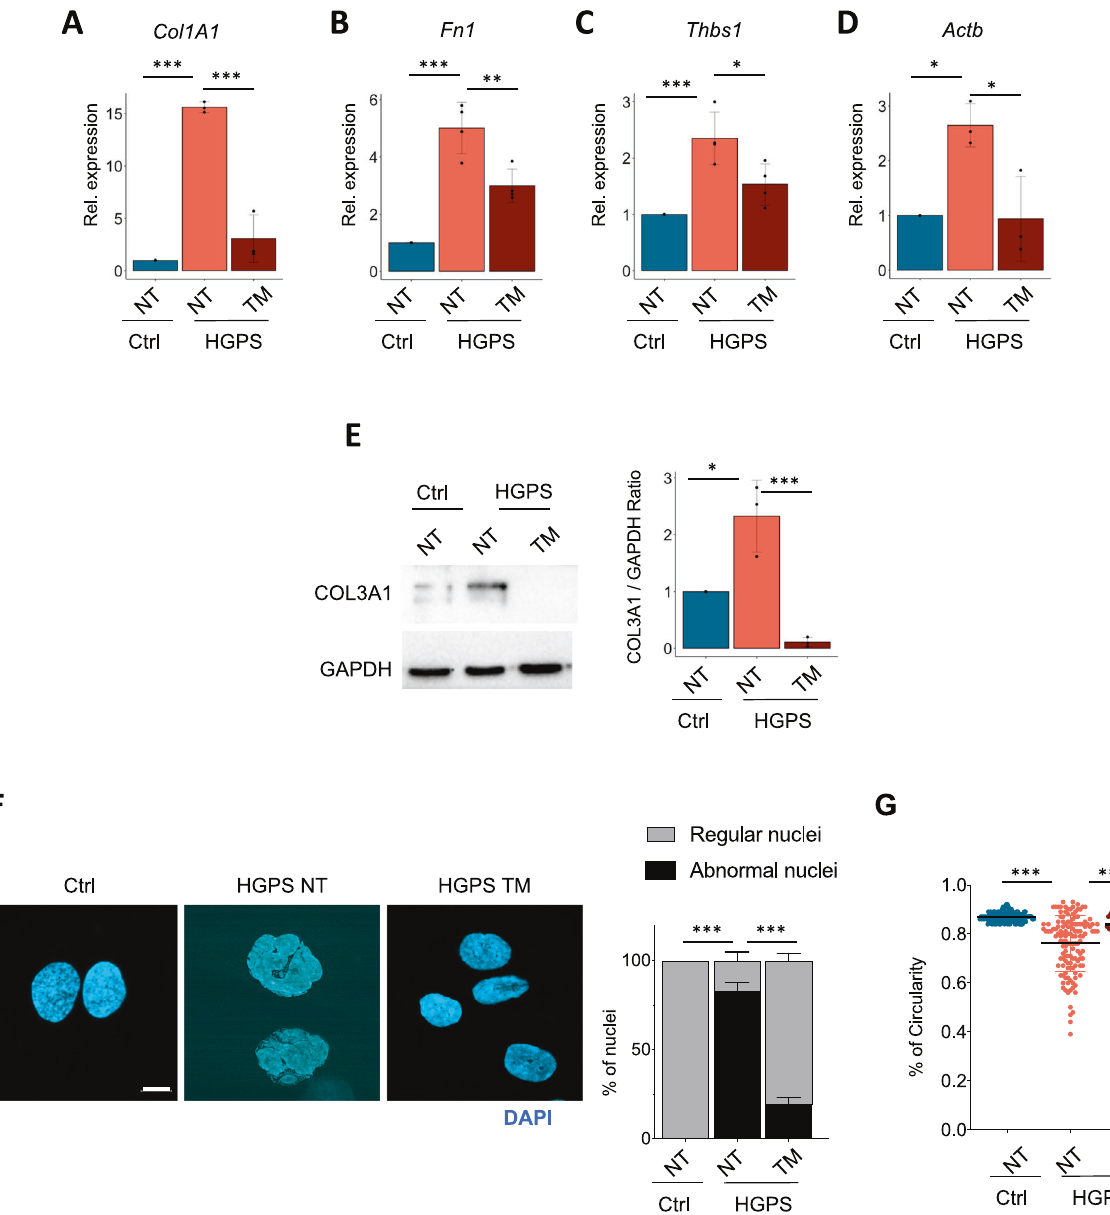
where the sum of the counts for all samples was >1. Genes were considered differentially expressed with Benjamini – Hochberg